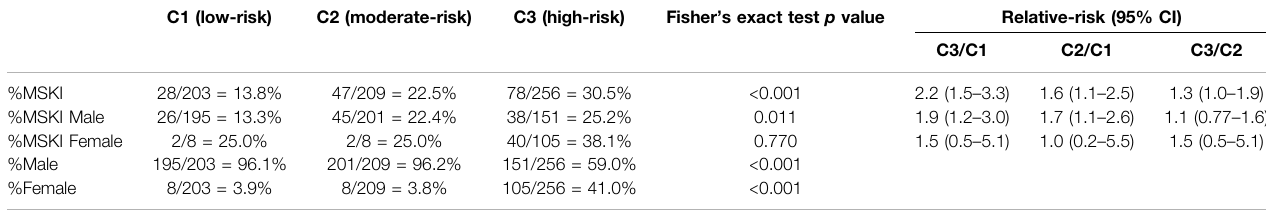
TABLE 3 | Proportions of MOCs with Lower Body and Torso Musculoskeletal Injury by Cluster.